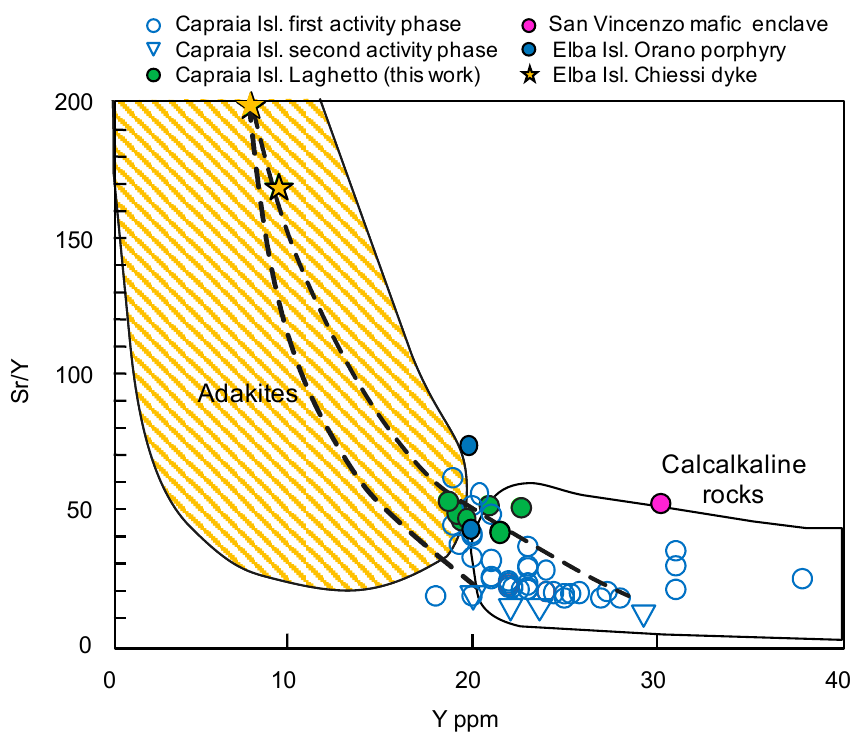
Figure 10. Y vs Sr/Y diagram to discriminate adakitic from typical arc rocks. Fields from Ribeiro et al. [20]. Dashed lines are two mixing curves between Elba dykes (Chiessi) and different Capraia samples. Note that the samples with high Sr/Y plot on these curves, and the Laghetto rocks plot at the transition between adakite and calcalkaline rocks.